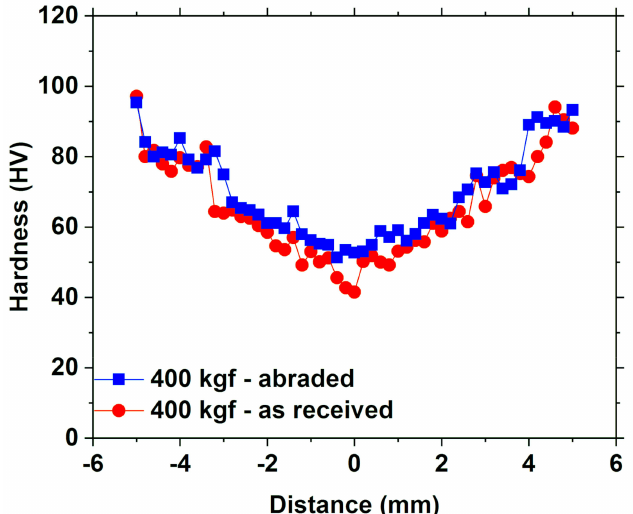
Figure 2. Measured hardness distribution of welds produced at the electrode force of 400 kgf.